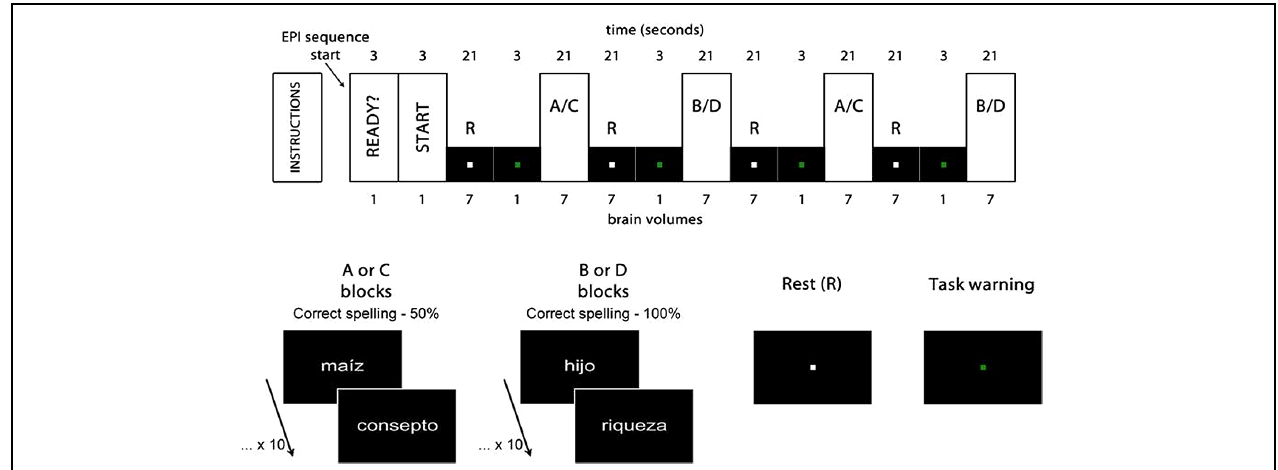
FIGURE 1 | Experimental design. Rest (R) and activation (A, B, C, and D) blocks. The first two brain volumes were eliminated from the analysis, as well as the four task warning volumes. Maíz (corn), hijo (son) and riqueza (wealth) are examples of words spelled correctly. Consepto (concept) is an example of a word spelled incorrectly, with an s instead of a c , thus generating a homophone